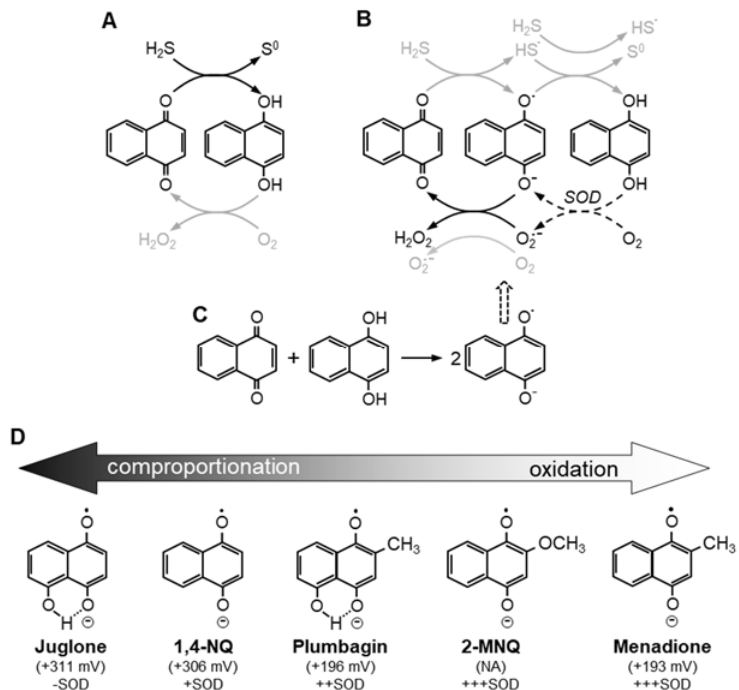
Figure 7. Proposed two-electron ( A ) and one-electron ( B ) reactions of 1,4-NQ with H 2 S and ( C ) the comproportionation reaction generating the semiquinone from oxidized and reduced 1,4-NQ. Gray arrows and chemical pathways indicate less favorable reactions, dashed gray arrows show pathway enhanced by SOD-catalyzed removal of superoxide. ( D ) Potential effects of ring substitutions on autoxidation or comproportionation in the initial one-electron oxidation of naphthohydroquinones. Naphthoquinones that readily comproportionate are minimally affected by SOD. Reduction potentials in in parentheses, -SOD, minimal effect of superoxide dismutase (SOD). +SOD, +++SOD moderate and large effect of SOD, respectively.